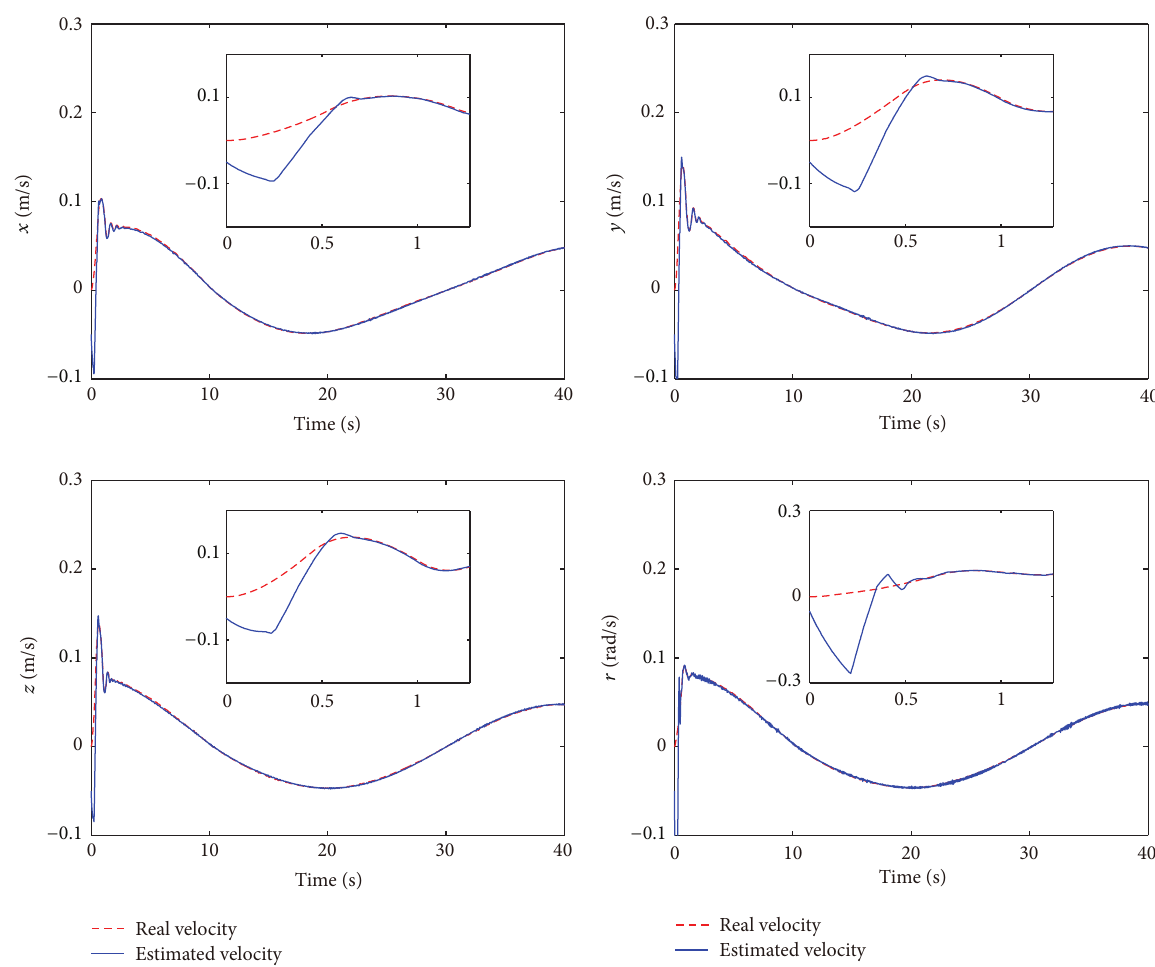
Figure 12: Estimated velocity and real velocity of output feedback FO-NTSMC with boundary